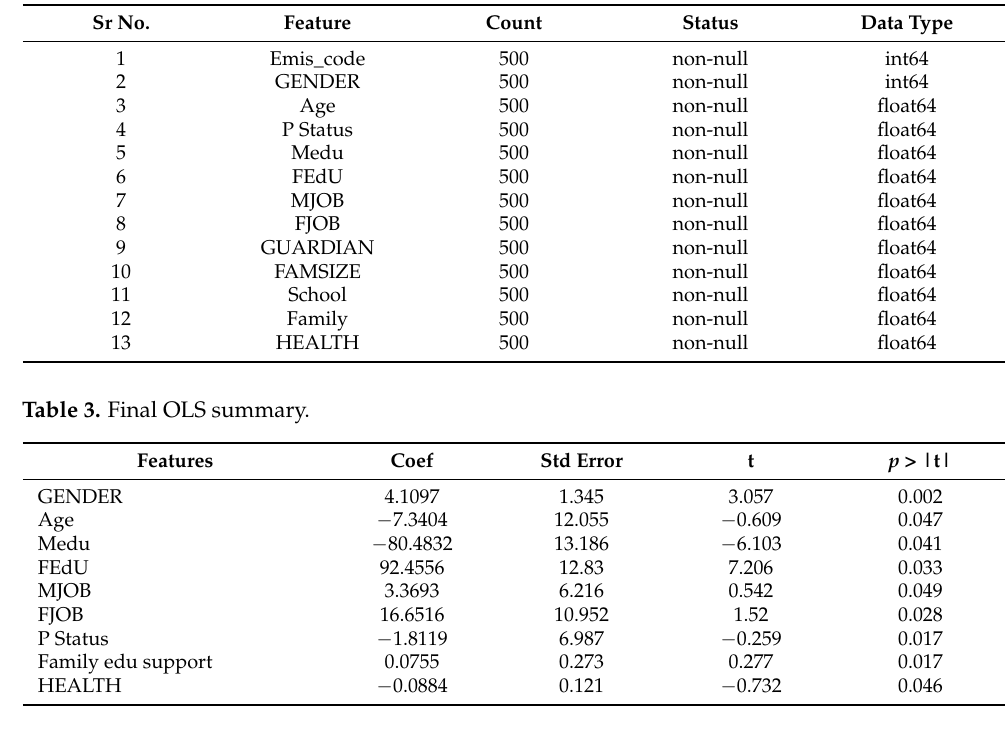
Table 2. After preprocessing of data.